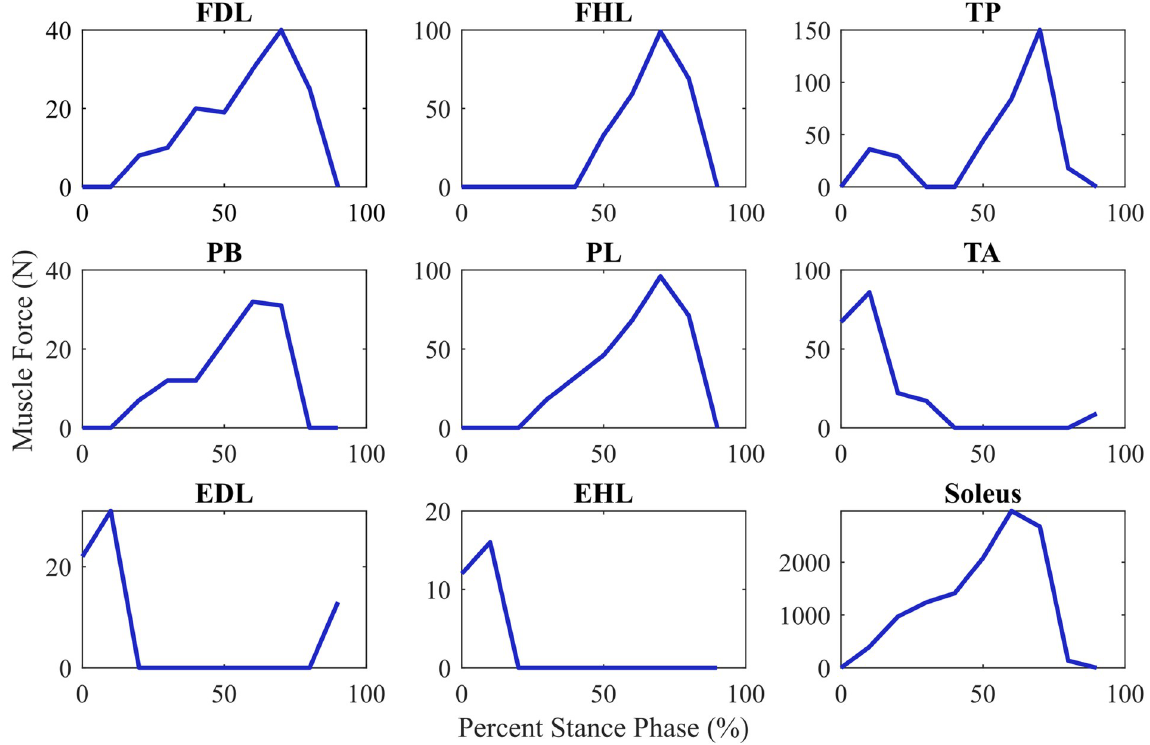
Fig 6. Generated muscle forces. Forces generated by nine extrinsic muscles of the lower limb during simulation of the stance phase of gait.